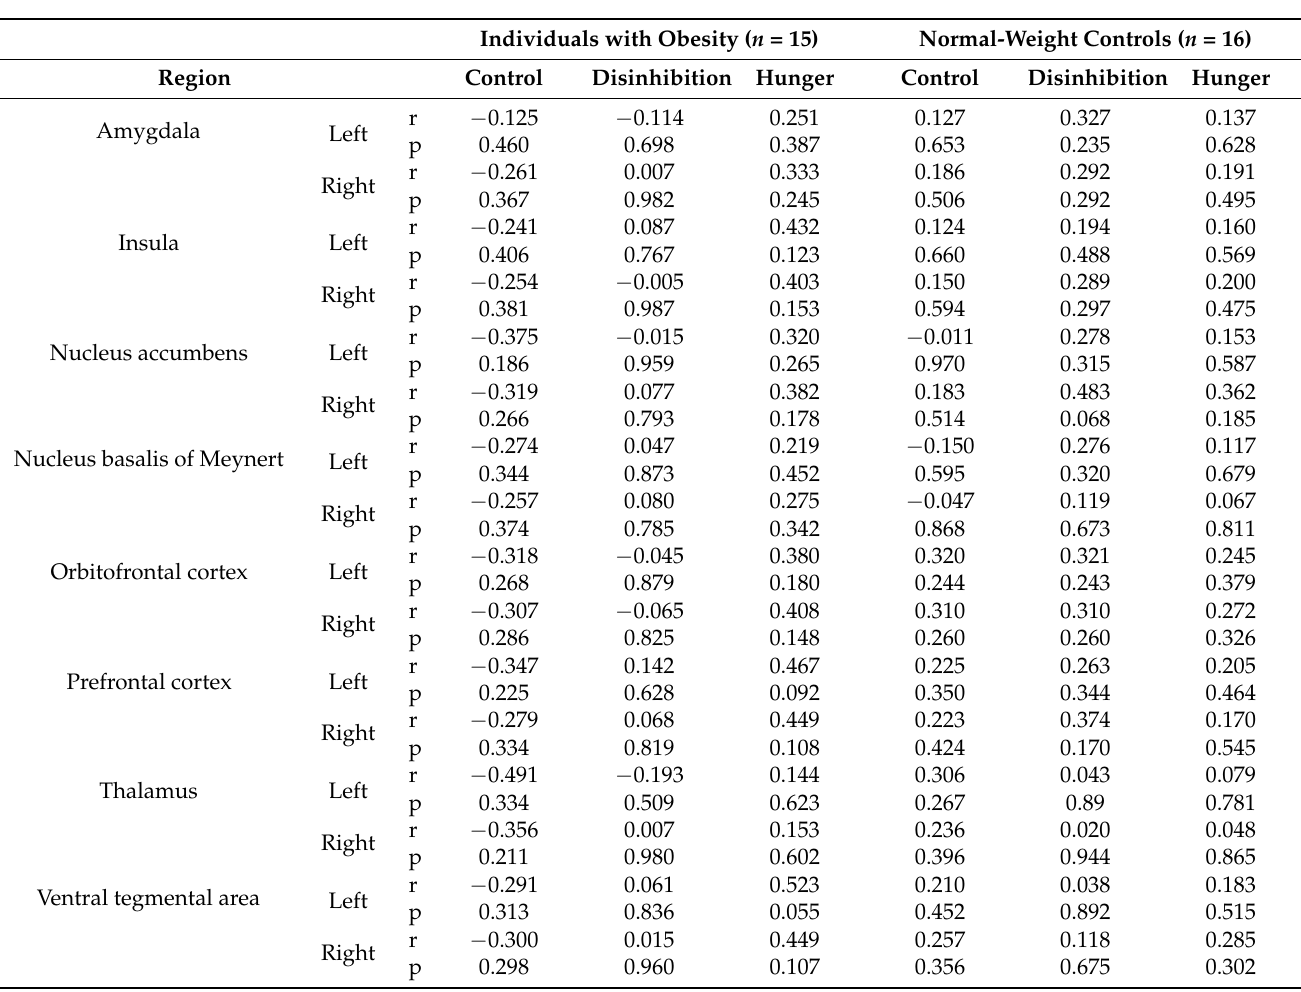
Table 3. Partial correlation of total distribution volume (V T ) with subscales of the Three-Factor Eating Questionnaire (cognitive control, disinhibition, and hunger) in individuals with obesity ( n = 15) and in normal-weight controls ( n =